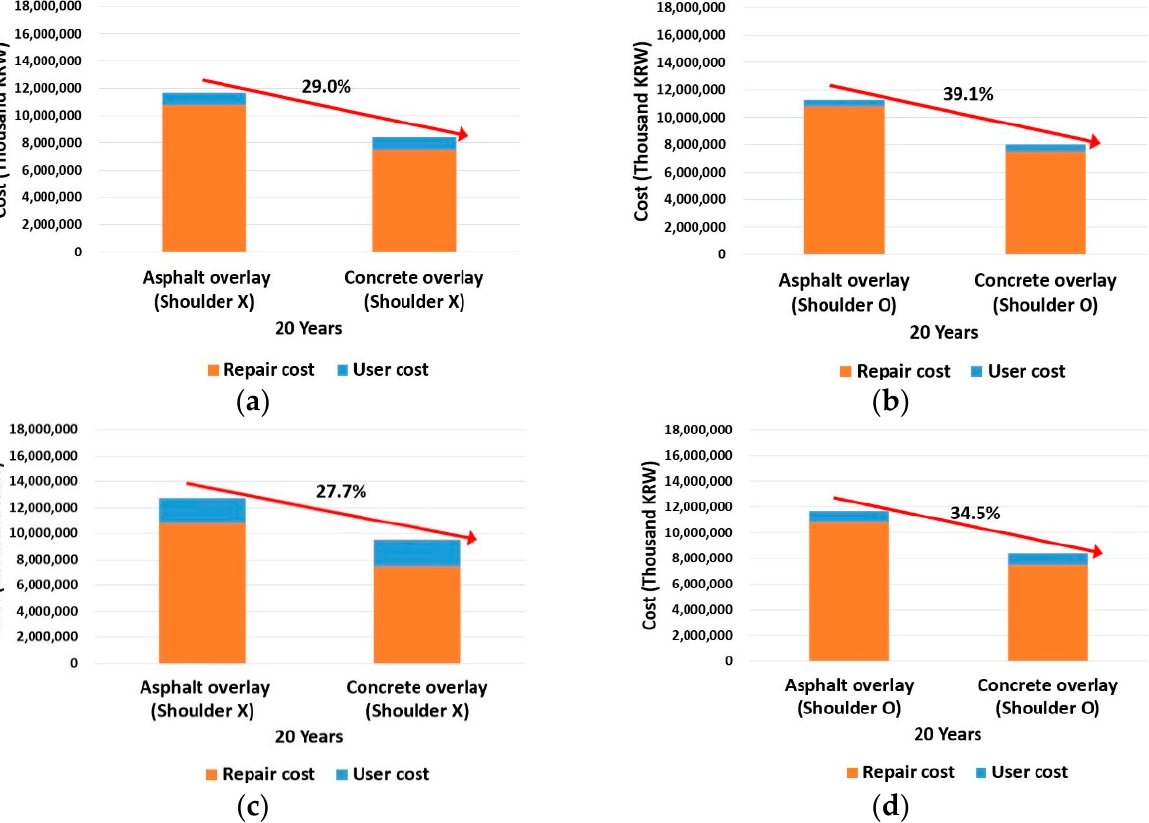
Figure 9. Economic analysis by 2-lane overlay method. ( a ) 2-lane 6000 AADT overlay economical (Shoulder X). ( b ) 2-lane 6000 AADT overlay economical (Shoulder O). ( c ) 2-lane 11,000 AADT overlay economical (Shoulder X). ( d ) 2-lane 11,000 AADT overlay economical (shoulder O).